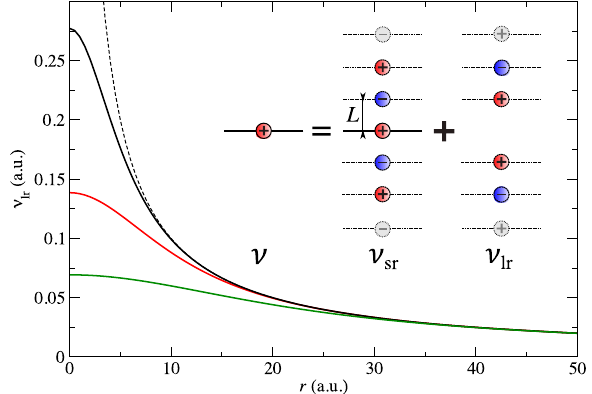
FIG. 2. Real-space representation of the long-range Coulomb kernel as defined in the text. The curves correspond to the choices L ¼ 5 a.u. (black), L ¼ 10 a.u. (red), and L ¼ 20 a.u. (green). The Coulomb potential 1 =r is shown as a dashed curve for comparison. The inset provides an intuitive illustration of the decomposition of Eq. (32) as an image-charge